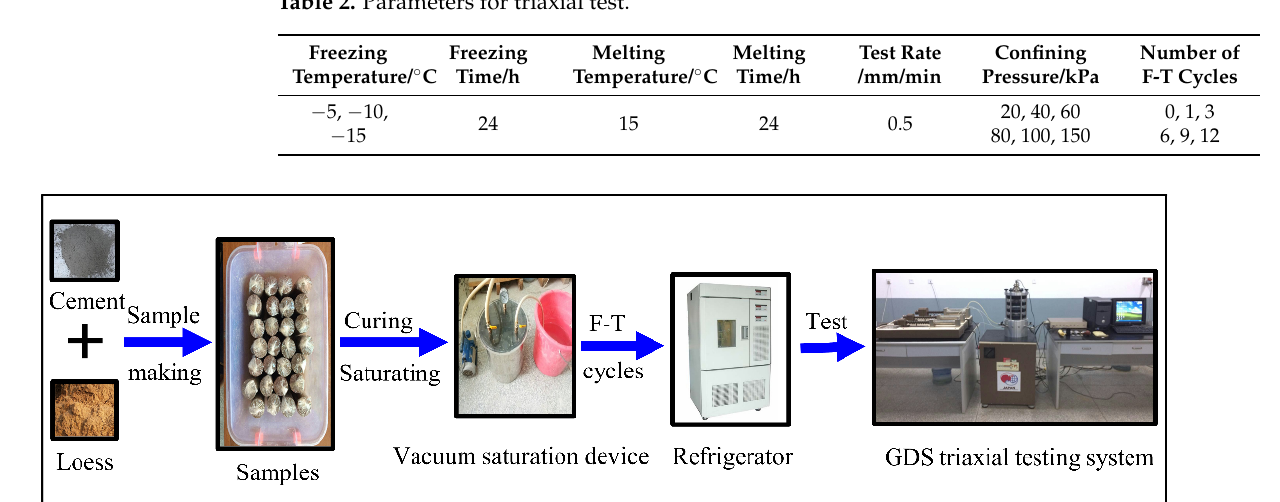
Figure 1. Schematic diagram of experiment process.